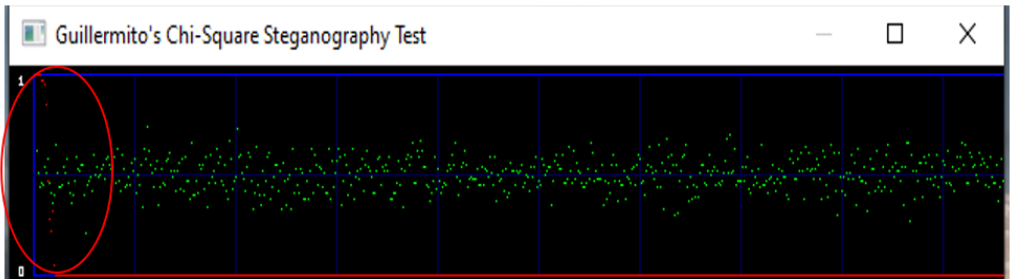
and red dots show that the probability is near zero which is flat showing no random data hidden in the image. hidden in the image.